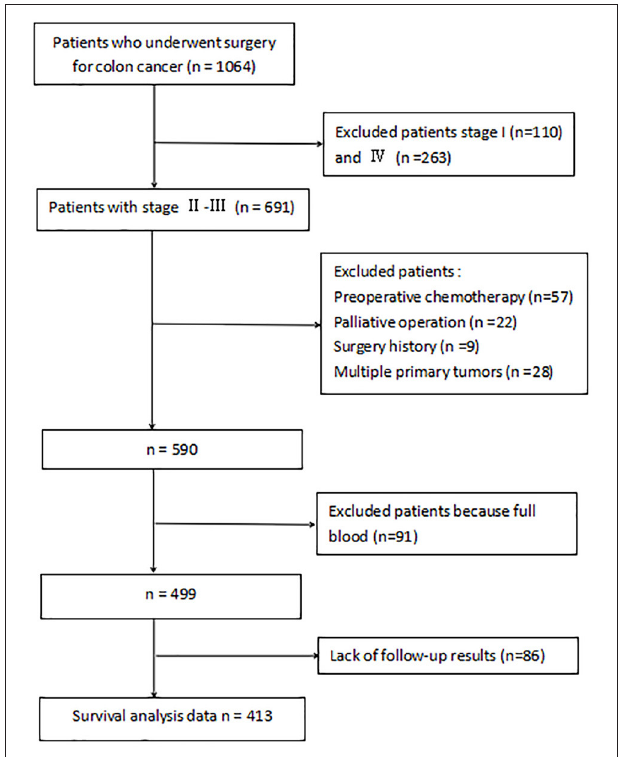
FIGURE 1 | The data screening